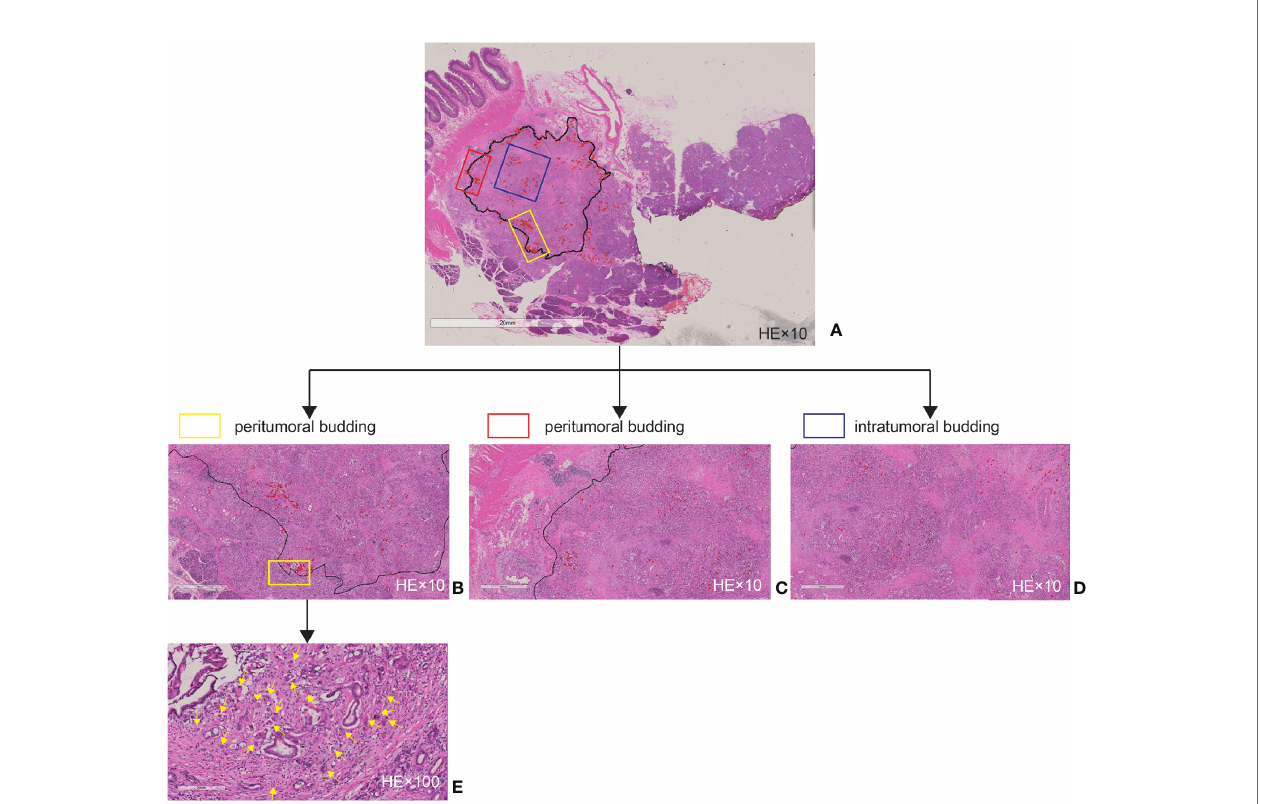
FIGURE 2 | Tumor budding as assessed by large sections. (A) Example of a whole slide image. (B) Magni fi ed high-power fi eld (HPF, ×10) area of (A) at the tumor front. (C) Magni fi ed HPF (×10) area of (A) at the tumor front. (D) Magni fi ed HPF (×10) area of (A) in the tumor center. (E) Magni fi ed HPF (×100) area of (B) . The black line delineates the tumor invasive front, and the red marks and yellow arrows indicate the tumor